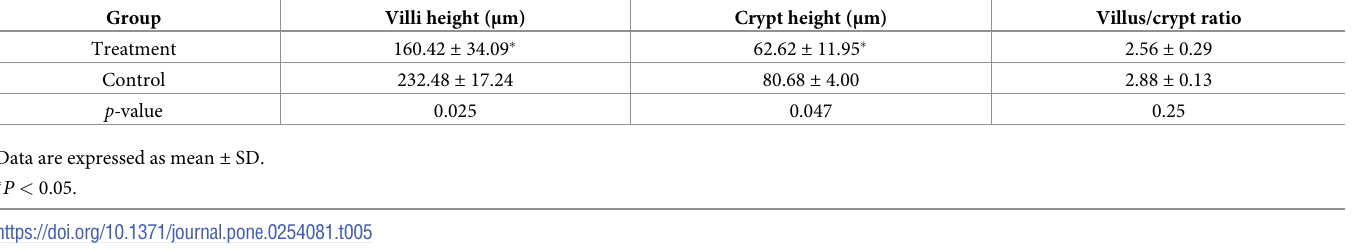
Table 5. Ileum mucosal architecture measurements of mice fed with E . thailandicus TC1 and the control diet. Group